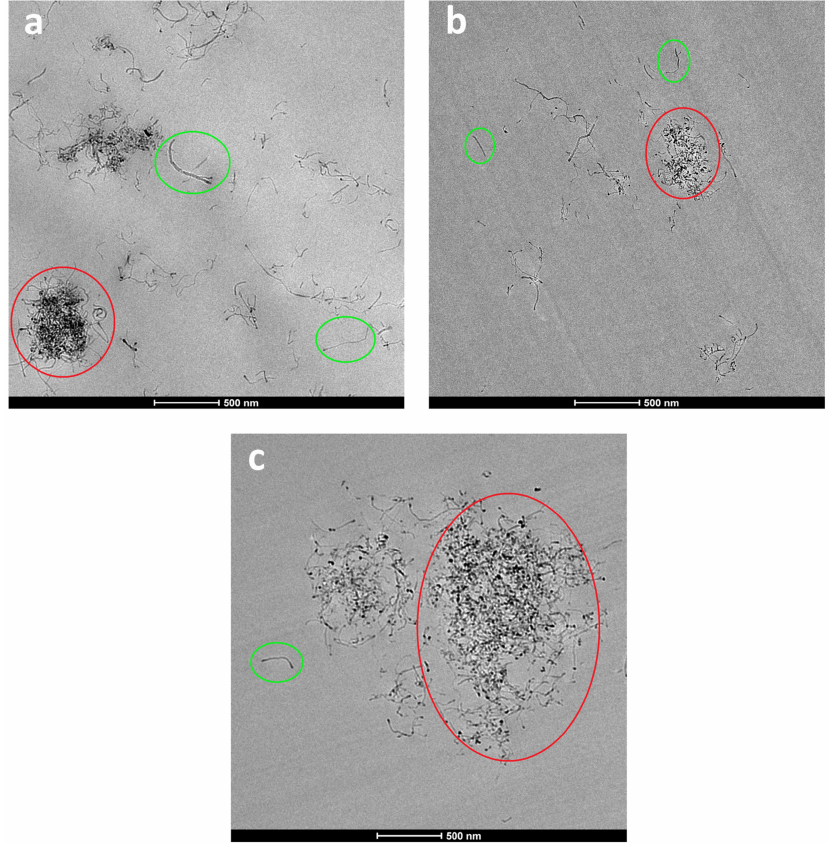
Figure 2. TEM micrographs of the epoxy/PCL/CNT NCs cured with ( a ) IL-P-TMPP, ( b ) IL-P-DCA, and ( c )